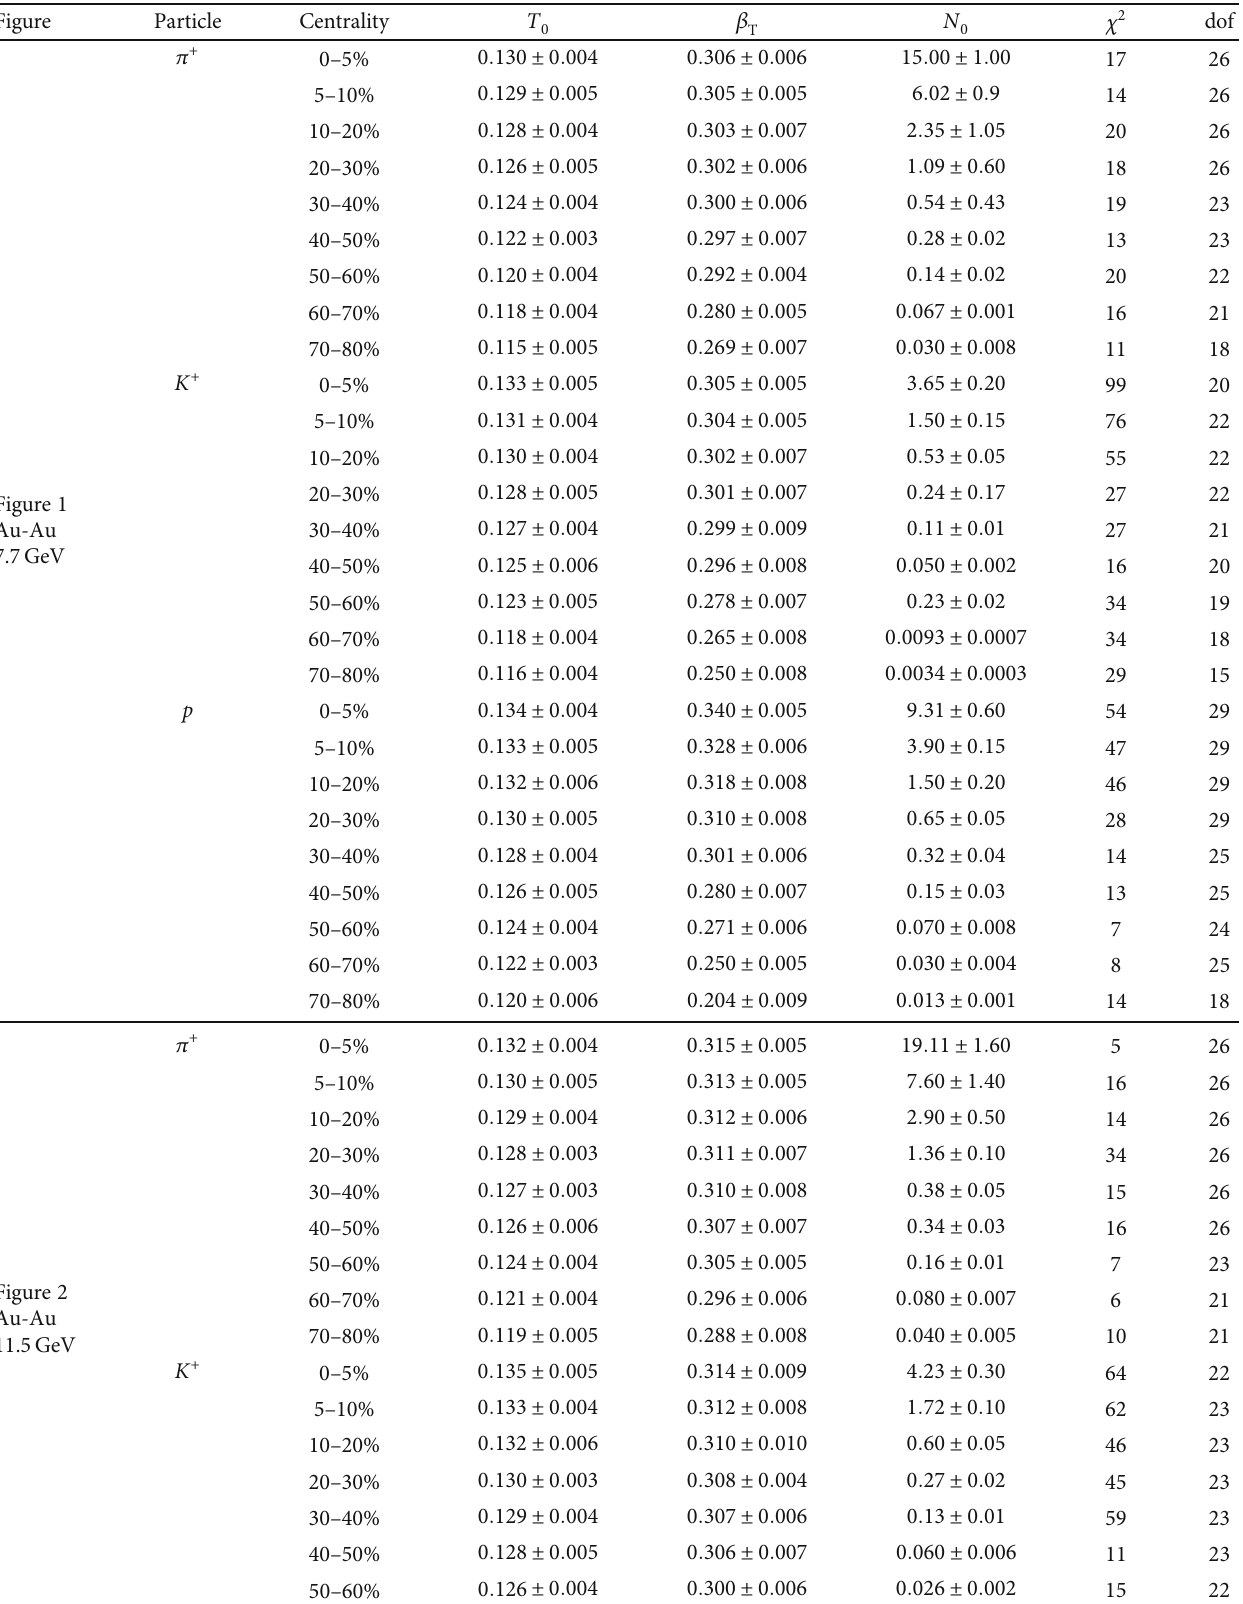
β 0 and T ), normalization constant (